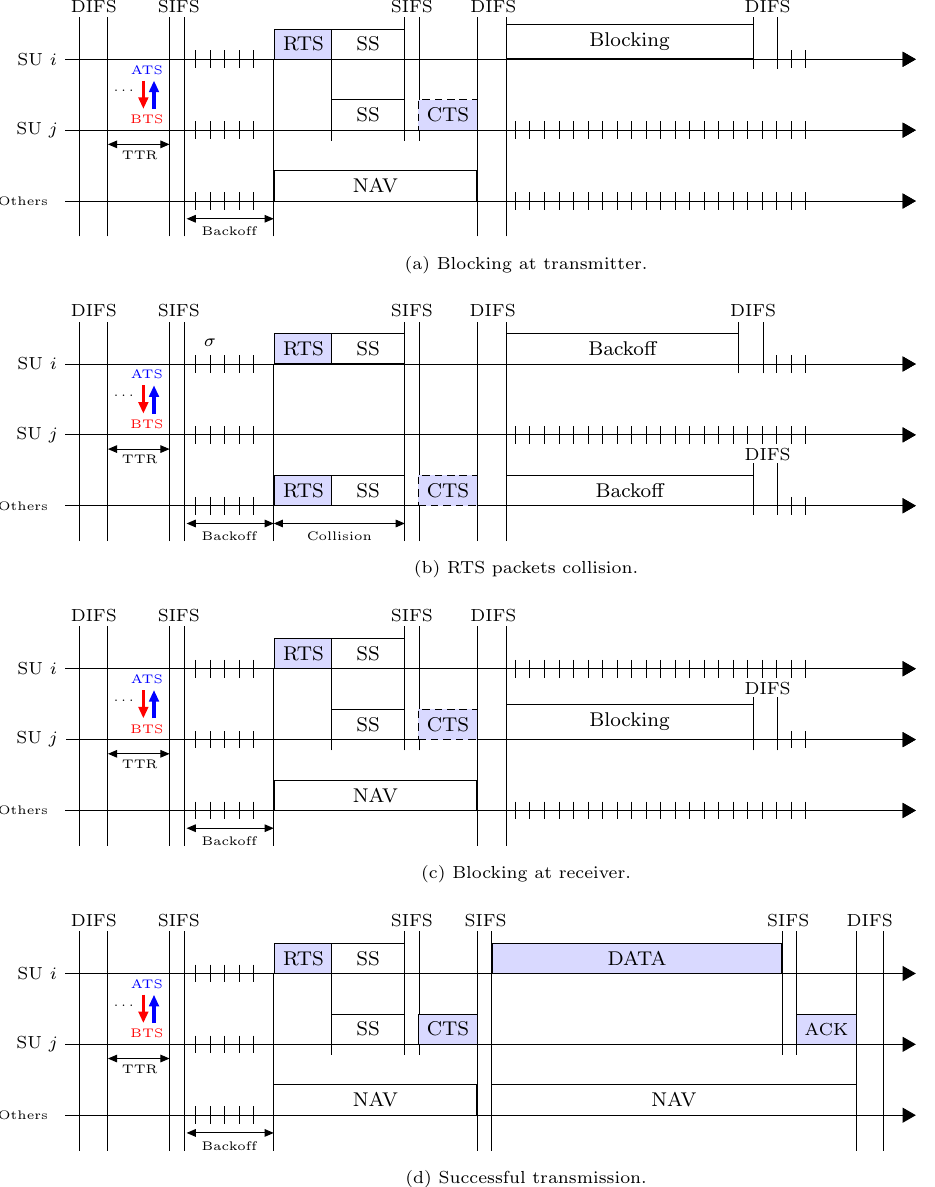
Figure 4. RSMA/CA access mechanism in the rendezvous-channel followed by the all possible events: ( a ) event e 1 ; ( b ) event e 2 ; ( c ) event e 3 ; ( d ) event e 4